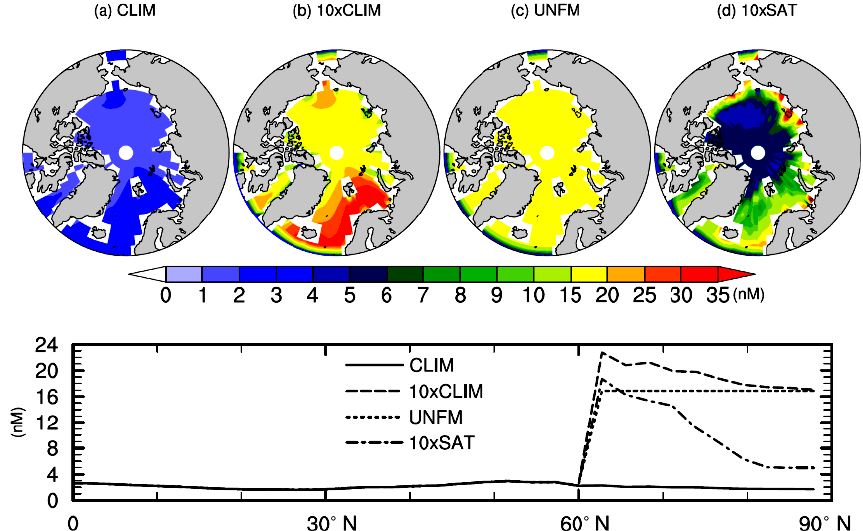
Figure 3. Annual mean distribution of surface seawater DMS concentration used in sensitivity simulations: (a) L10 DMS climatology, (b) L10 DMS climatology multiplied by 10 in the Arctic region, (c) uniform distribution of DMS, and (d) satellite-based DMS climatology multiplied by 10. The bottom panel shows zonal mean